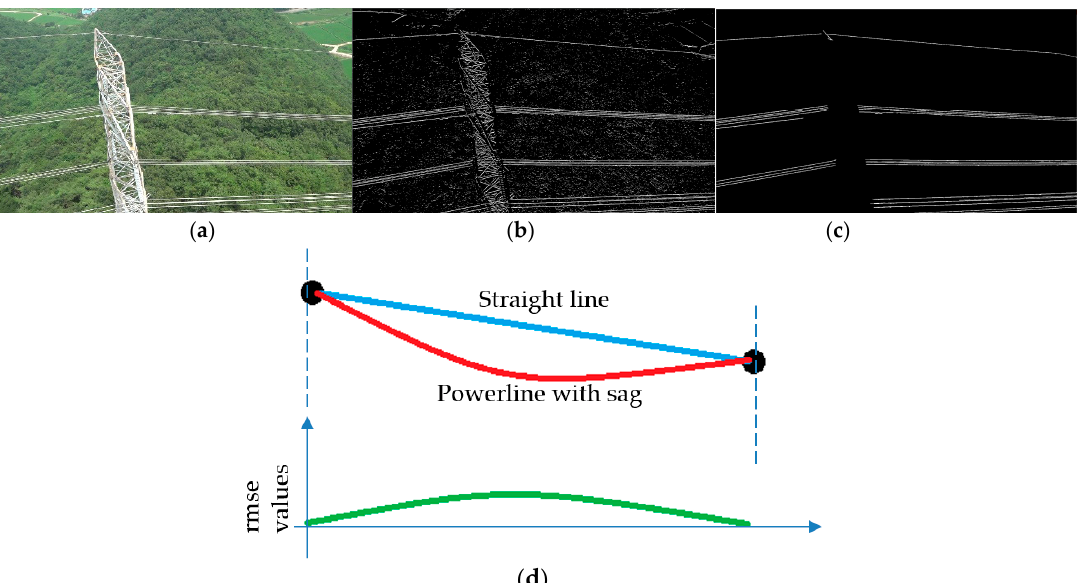
Figure 4. ( a ) Aerial view of the transmission tower with power line. ( b ) The edge equivalent is very noisy due to the presence of trees and cluttered objects in the background. ( c ) The use of custom shaped Sobel kernel helps in removing the noise. ( d ) Imaginary straight blue line connecting the endpoints of the power line (red) having a sag. Green curve shows the root mean square error (RMSE) values computed between the straight line and the power line.